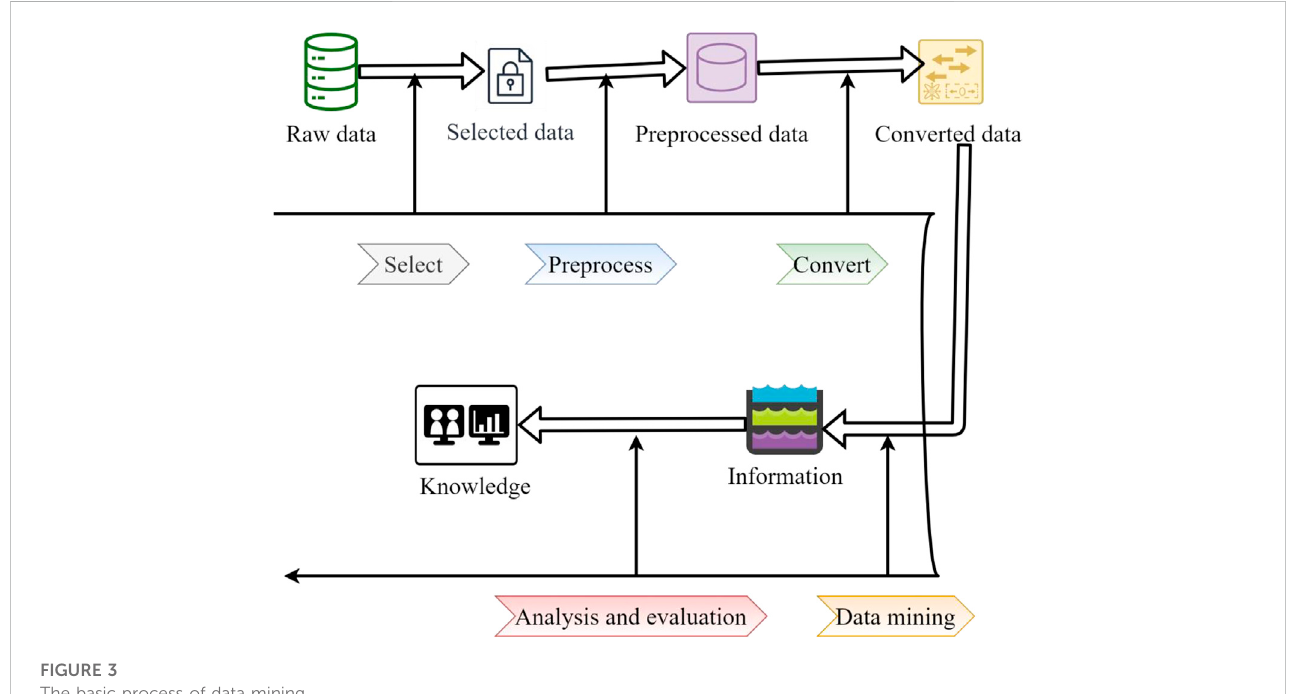
FIGURE 3 The basic process of data